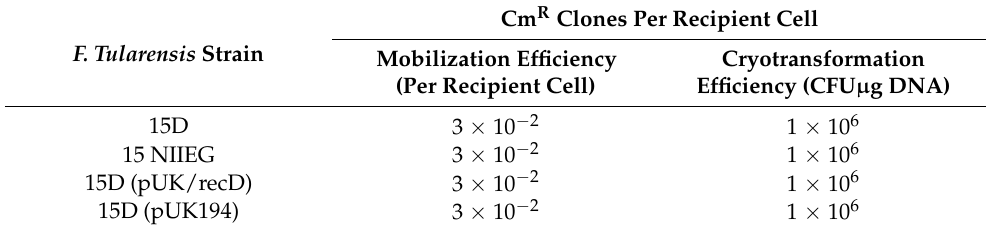
Table 4. Efficiency of the transfer of pHVmob plasmid into F. tularensis strains.